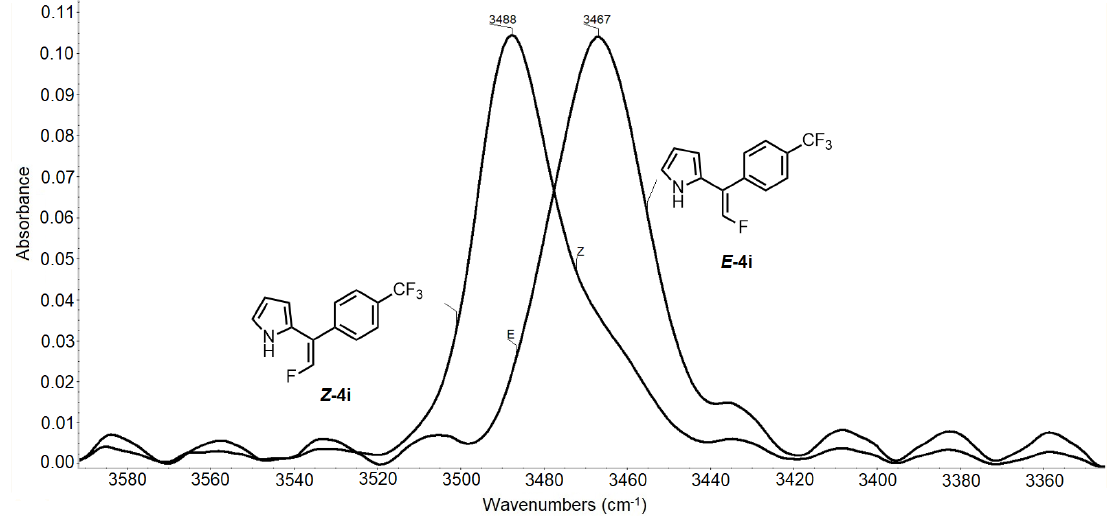
Figure 6. Fragment of IR spectra of the isomers of 4i with NH vibrations.